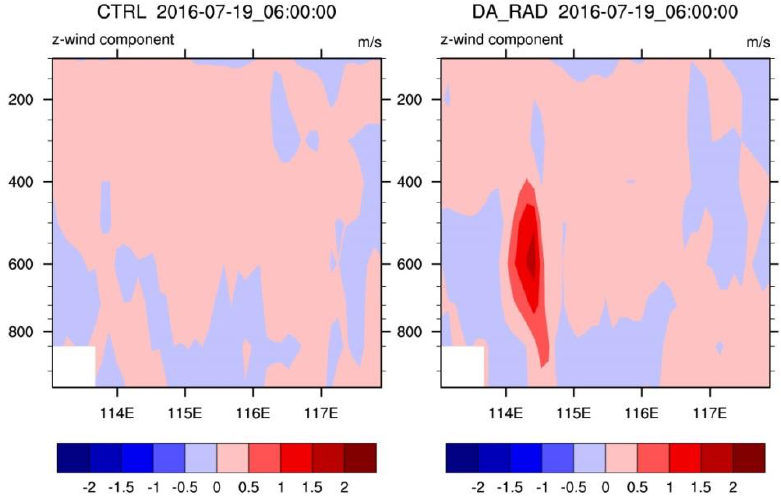
Figure 13. Cross sections of vertical velocity (m/s) along 38.5 °N from the 12-h forecasts of CTRL and DA_RAD experiments initialized at 1800 UTC 18 July 2016.